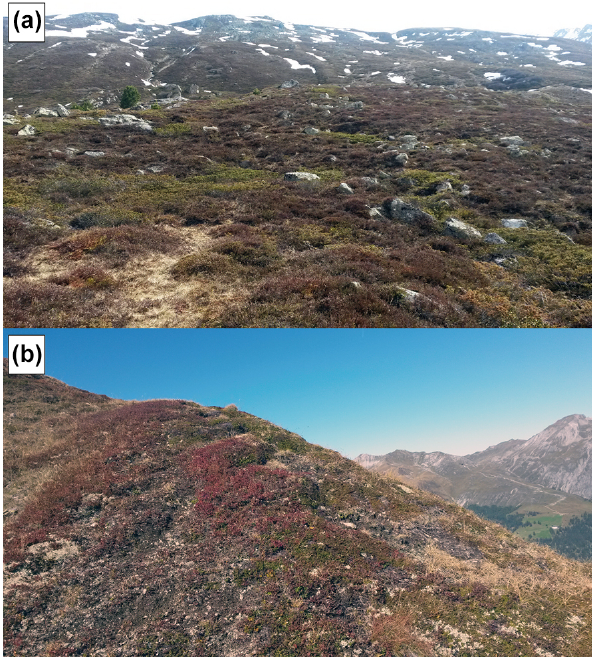
Figure 10. (a) Photograph of the bushes that rise up to 0.50m above ground and patches of low grass at the test site Tschuggen. (b) Pho- tograph of the shallow vegetation at the test site Brämabühl with maximum elevation of approximately